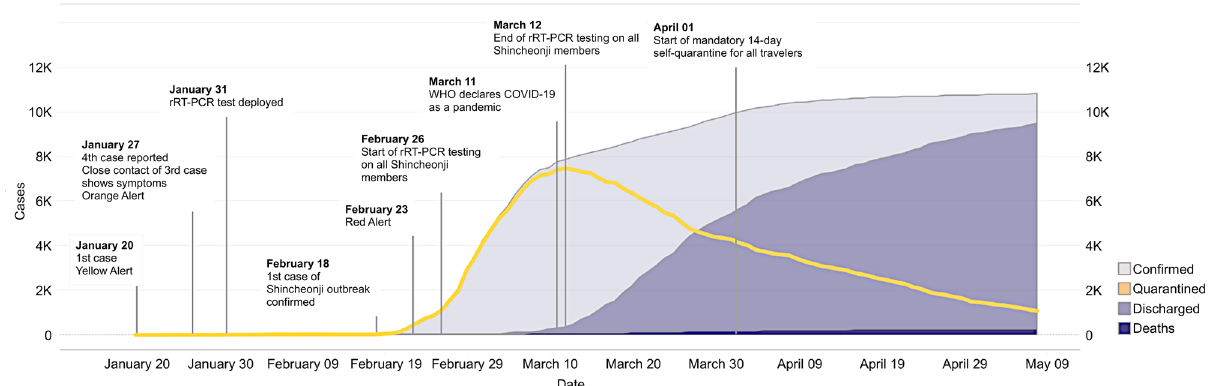
Figure 1. South Korea’s COVID-19 outbreak and intervention